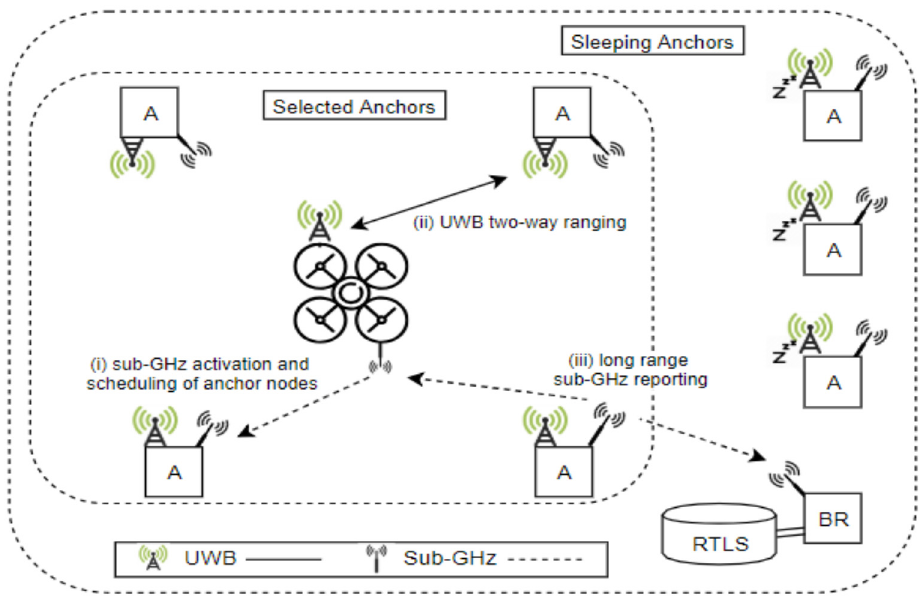
Figure 11. UWB tag-based localization.